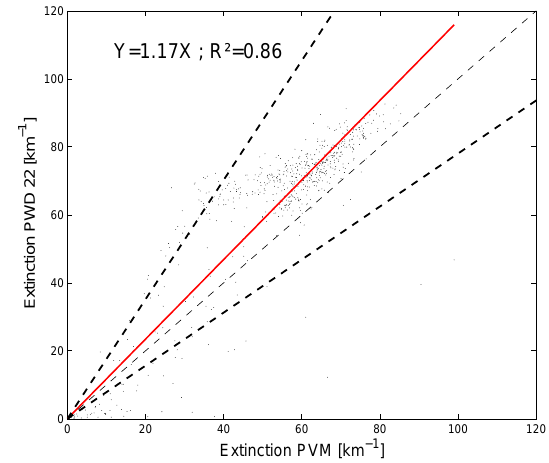
Figure 6. Scatter plot of the PWD and PVM 5min average extinc- tion coefficients. The bold dashed lines show the instrumental errors applied to the fit. The 99% confidence interval of the slope value was estimated to be [1.156,